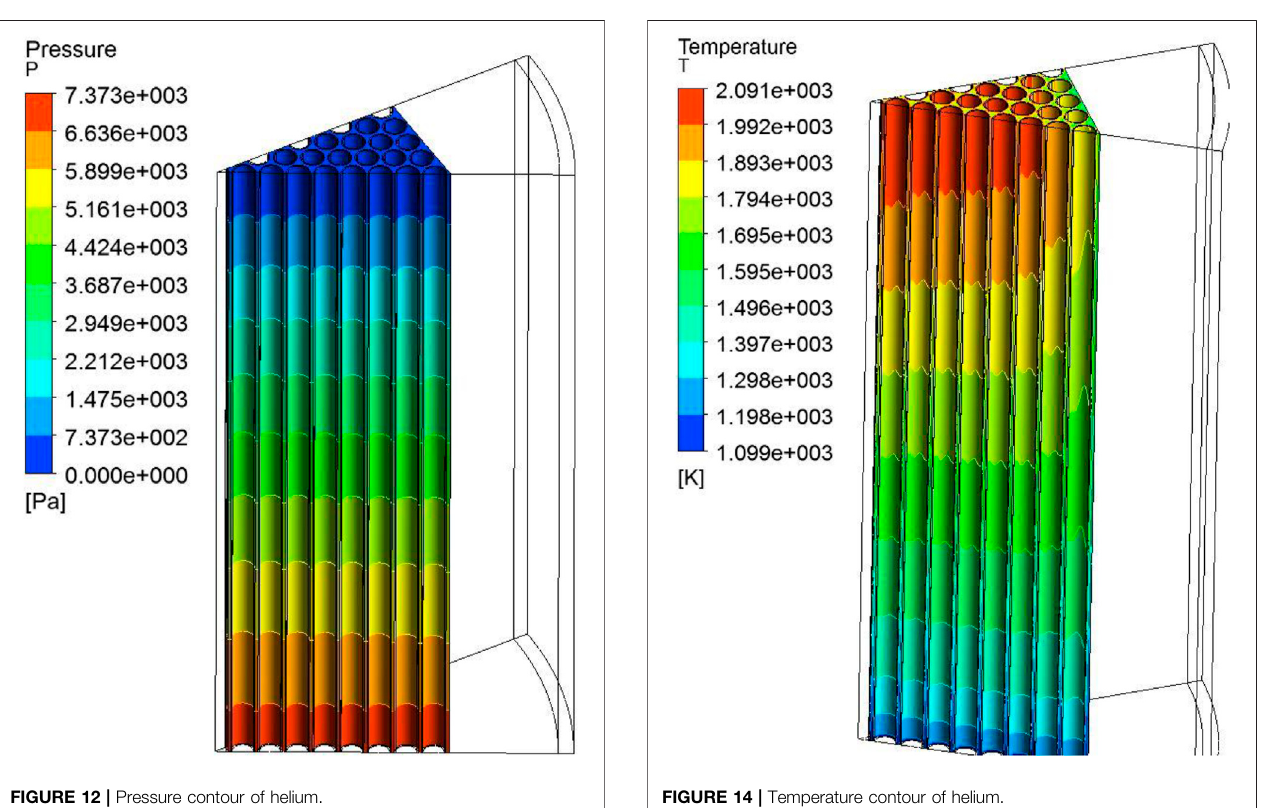
FIGURE 12 | Pressure contour of helium.